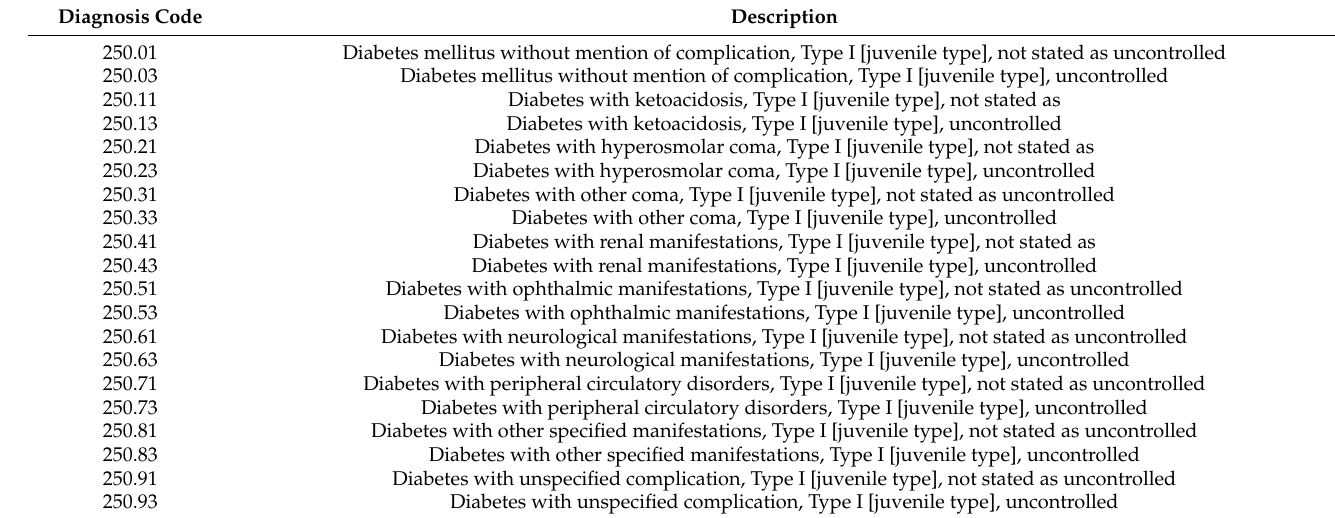
Table A1. ICD-9-CM codes used to identify diagnoses of type 1 diabetes